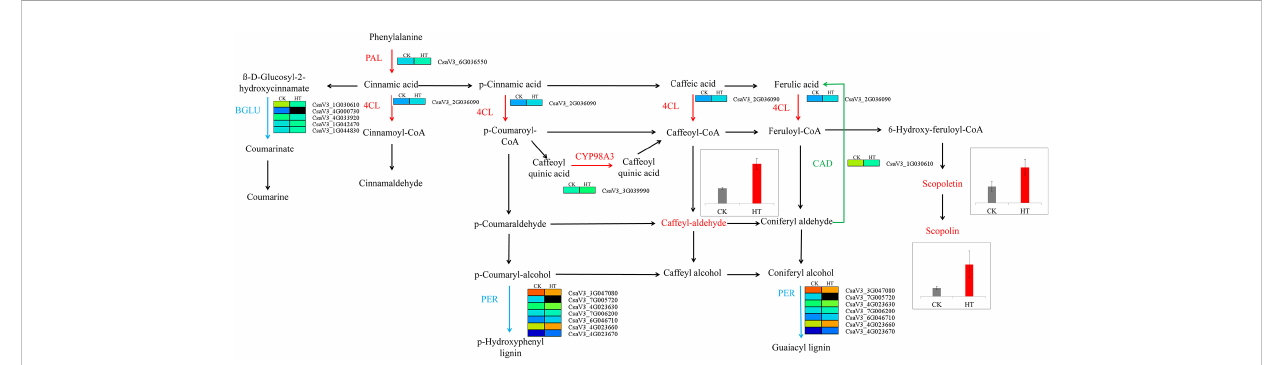
FIGURE 6 Predicted phenylpropanoid biosynthesis pathways under high-temperature stress. PAL, phenylalanine ammonia-lyase; 4CL, 4-coumarate-CoA ligase; BGLU, beta-glucosidase; PER,